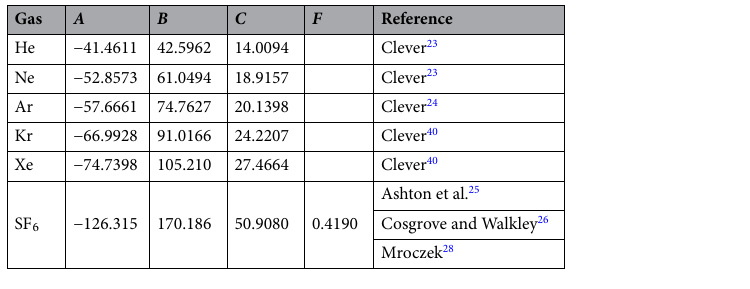
Table 2. Sts that fit Eq. (5).